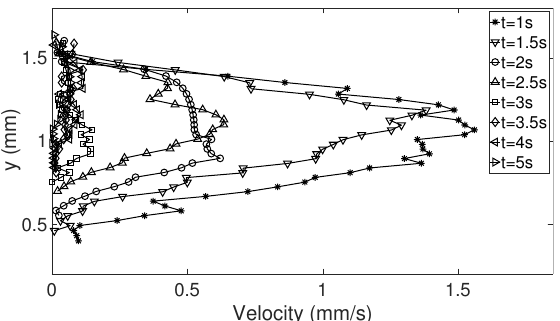
Figure 12. The magnitude of the velocity along the symmetry line for T plate = 261.15 K when t = 1–5 s.